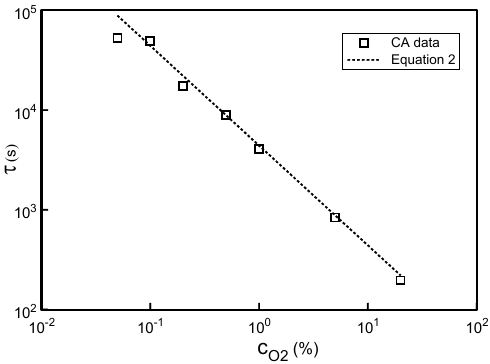
Figure 4. c O dependence of time constant τ (symbols) from CA data fitted using Equation (1). Figure 4. c O 2 dependence of time constant  (symbols) from CA data fitted using Equation (1). The 2 The dashed line represents the expected variation from Equation dashed line represents the expected variation from Equation (2).